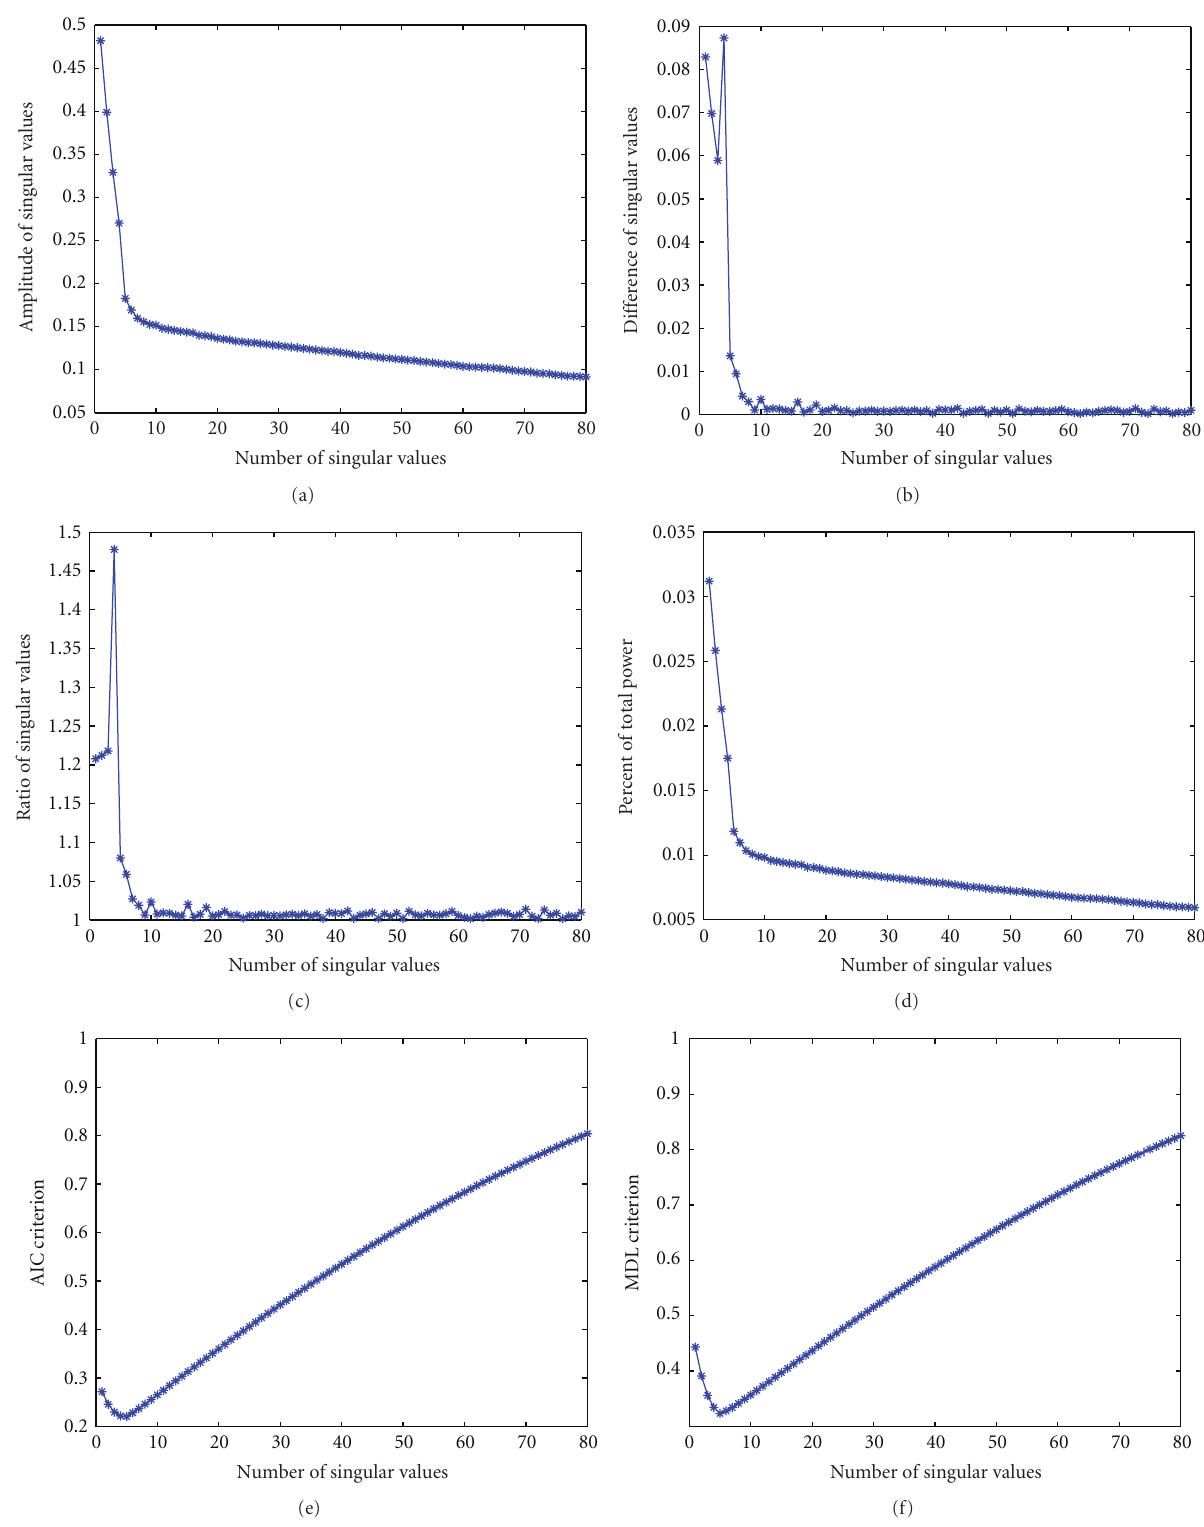
Figure 16: Example 4: Multiple (five) targets (a) amplitude of singular values ( s m ), (b) di ff erence of singular values ( s m − s m +1 ), (c) ratio of singular values ( s m /s m +1 ), (d) power in singular values ( s m / tr[ X ]), (e) AIC function of singular values (10), and (f) MDL function of singular values